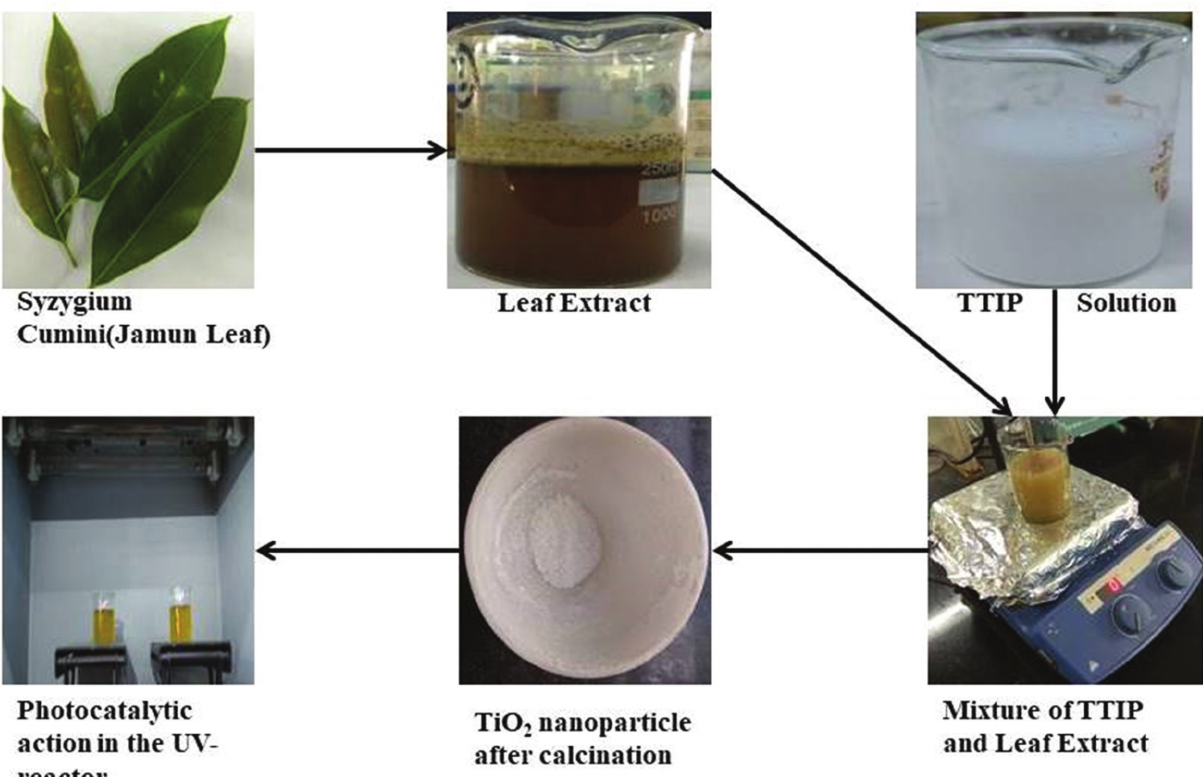
nanoparticle from Syzygium cumini leaf 2